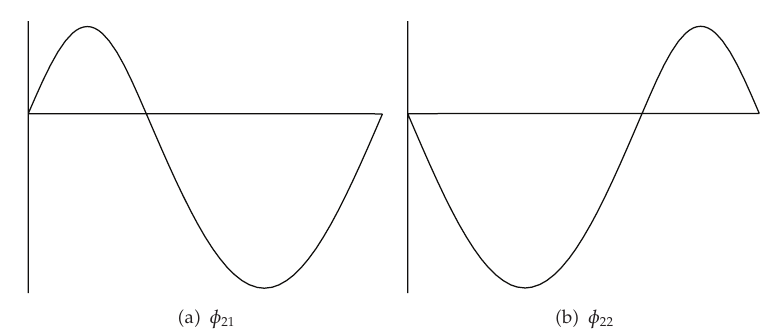
Figure 1: Eigenfunctions for (cid:3) α,β (cid:5) ∈ C 2 with α > β .